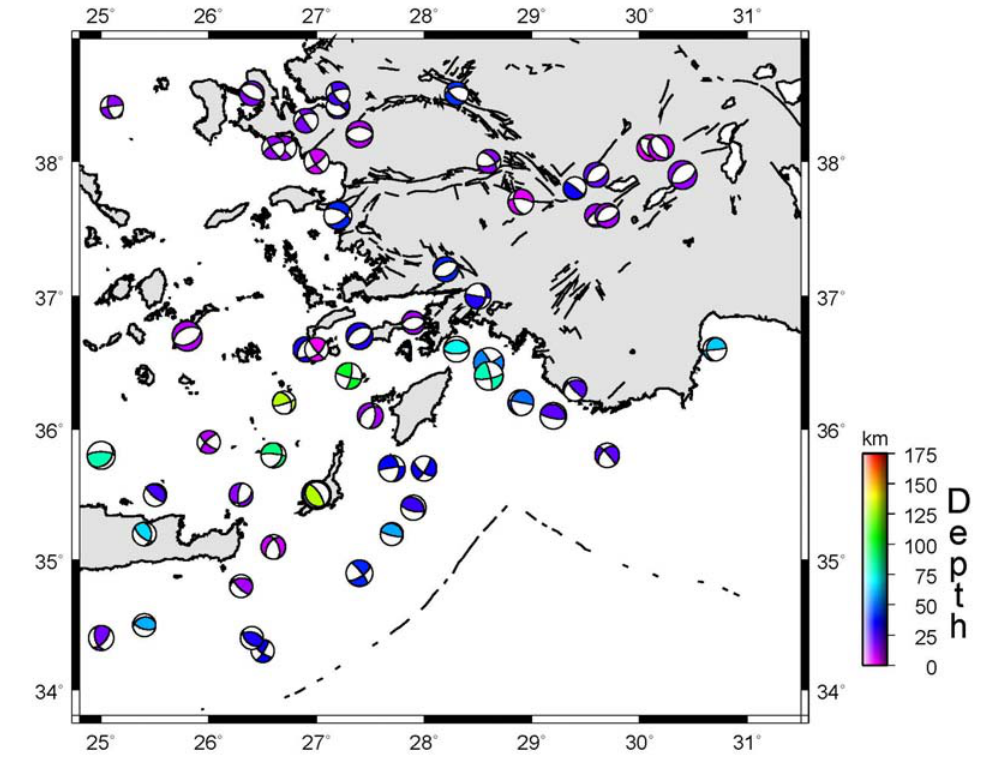
Figure 2 . The focal mechanisms of the earthquakes in the Southwest Anatolia (M > 5.5)